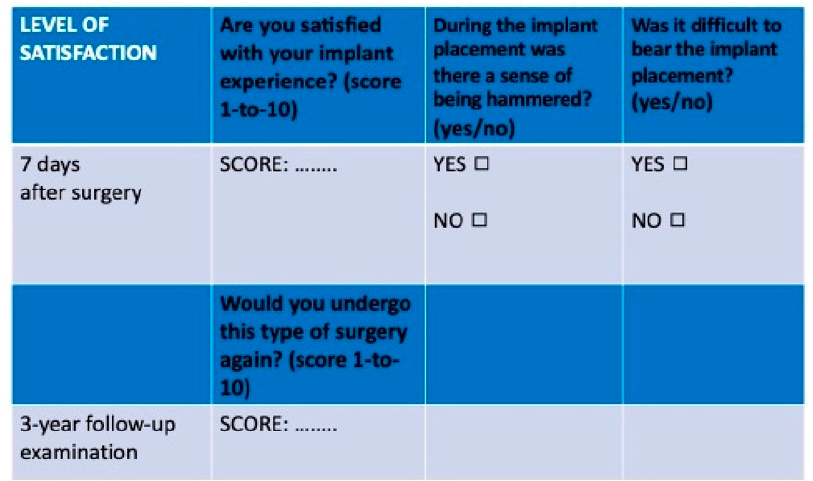
Figure 5. Level of satisfaction: Each patient had to report it seven days after surgery and at three-year follow-up examination.